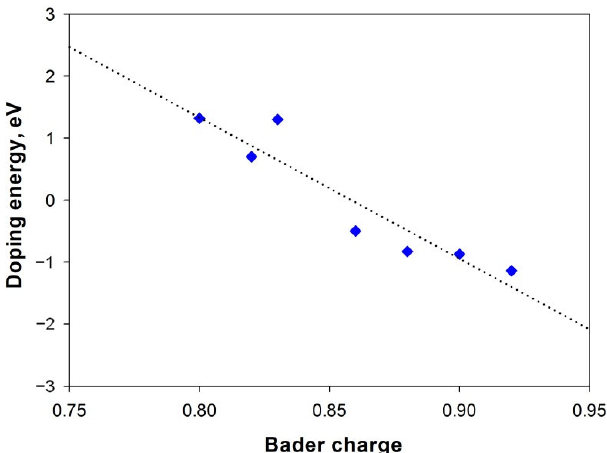
Figure 2. Variation of doping energy with Bader charge for various dopants. The dotted trend line is a guide to the eye.